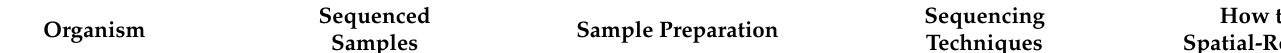
Table 1. Current advances in spatial transcriptomic studies in developmental